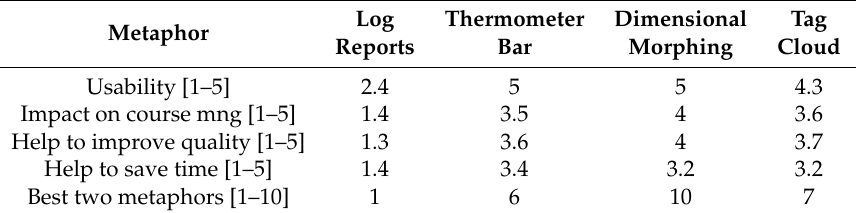
Table 2. Qualitative